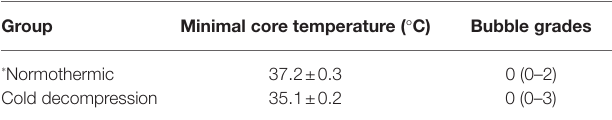
TABLE 1 | Minimal core temperature during decompression vs. maximal bubble grades observed post-dive in rats exposed to simulated